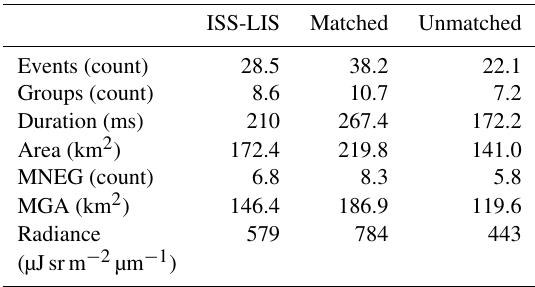
MNEG: maximum number of events per group. MGA: maximum group